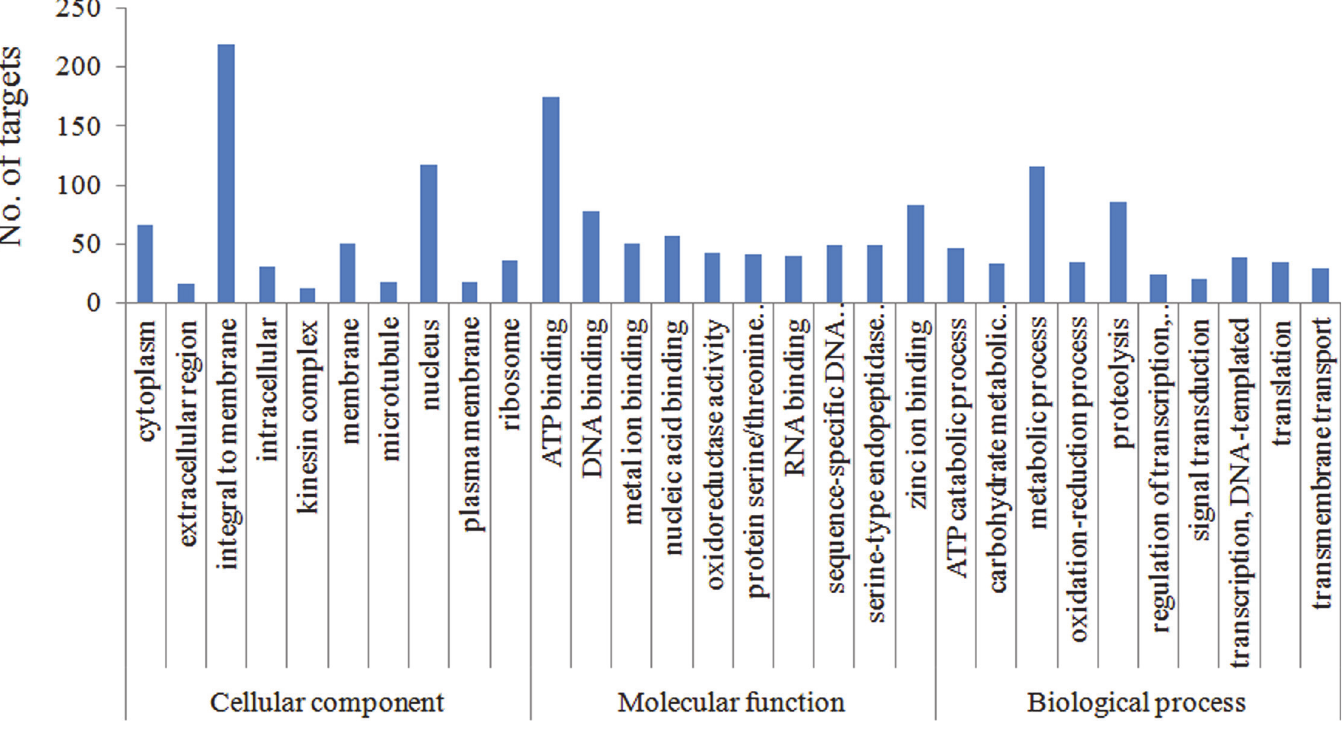
Fig 7. Gene ontology classification of the target genes for the selected miRNAs. Gene ontology (GO) term was assigned to each target gene based on the annotation and were summarized into three main GO categories (biological process, cellular component, molecular function) while only the top 10 sub categories are